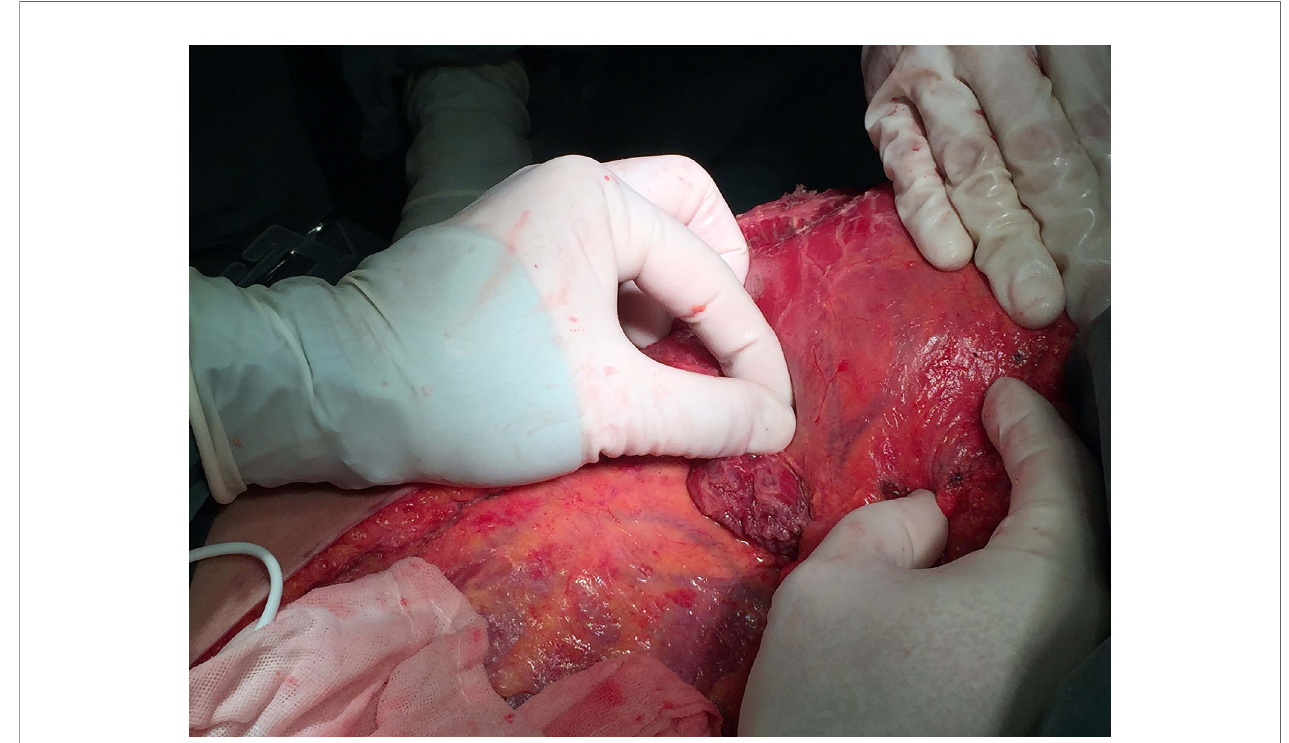
FIGURE 1 | A 42-year-old woman who was diagnosed with invasive carcinoma of the breast and axillary lymph node metastasis. The surgeon was protecting the vessels to separate the latissimus dorsi muscle during latissimus dorsi fl ap breast